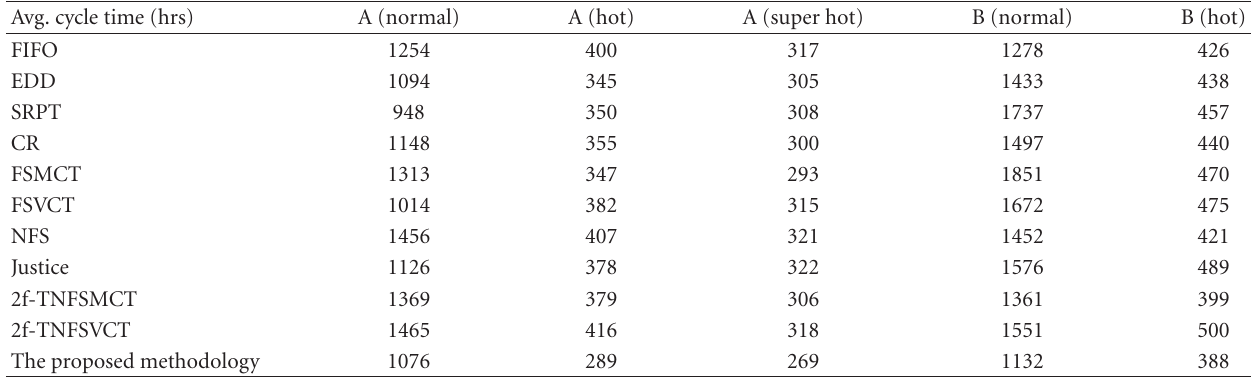
Table 3: The performances of various approaches in the average cycle time.